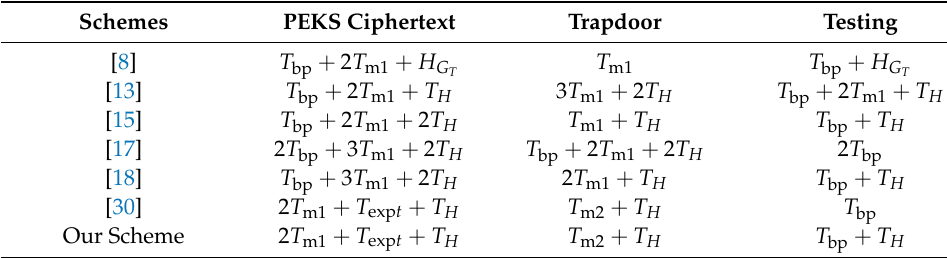
Table 3. Computational overhead.